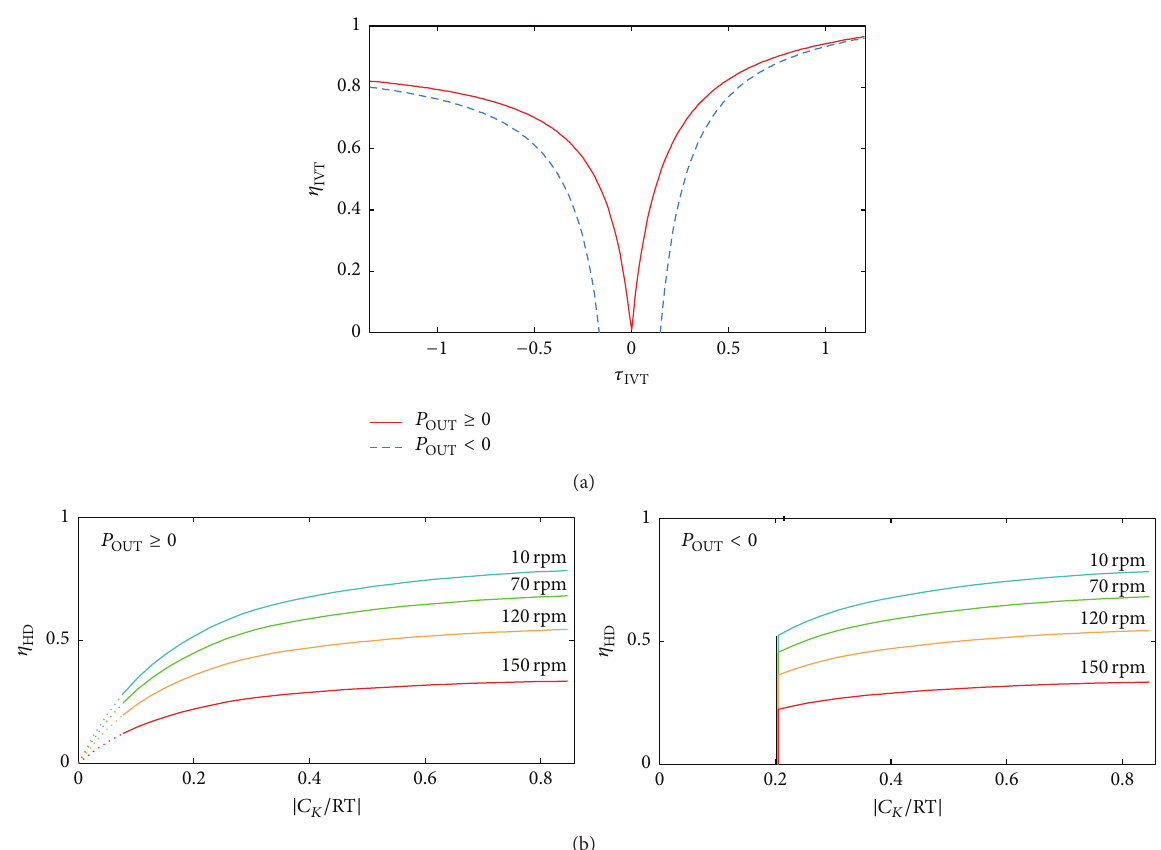
Figure 3: Efficiency maps of the IVT (a) and of the HD gear (b) obtained through detailed efficiency models which distinguish the performance of the transmission devices in forward ( 𝑃 OUT ≥ 0 ), revrse ( 𝑃 OUT < 0 ), and irreversible motion conditions. In (a) 𝜂 IVT is given as a function of 𝜏 IVT whereas 𝜂 HD is given as a function both of the output motor speed and of the torque at the output shaft normalized to the Rated Torque (RT) of the HD gear